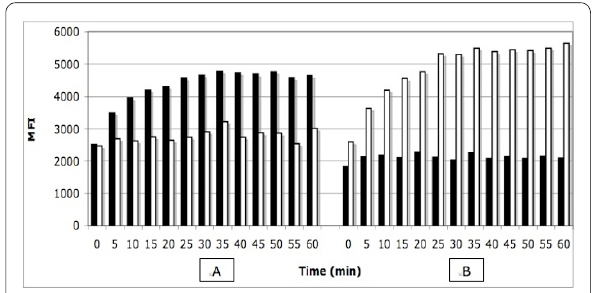
Figure 1 Effect of temperature on the kinetic of hybridization . Panel A; homozygous wild type DNA, panel B: homozygous mutated DNA. Black bars correspond to the wild type probe (V617Fwt) and white bars correspond to mutated probe (V617Fmut). MFI: median flu- orescent intensity.